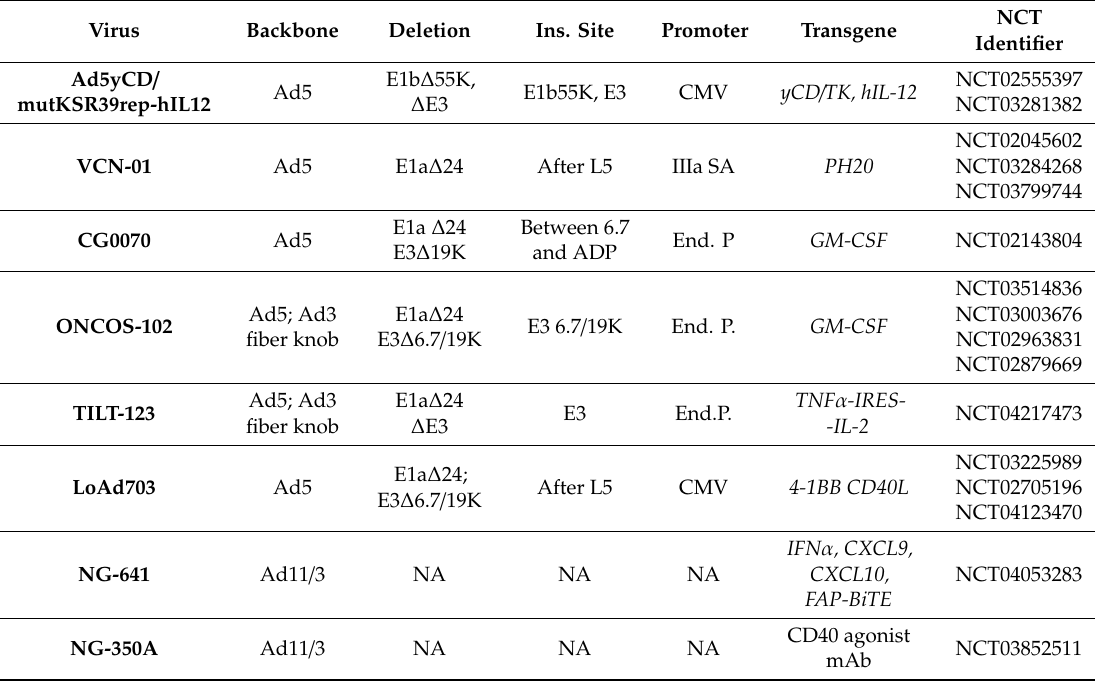
Table 1. Armed oncolytic adenoviruses in clinical